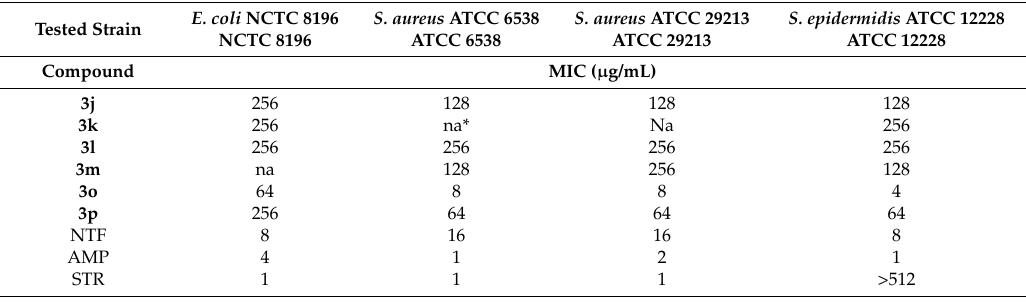
Table 6. In vitro antibacterial activity of 3j , 3k , 3l , 3m , 3o , 3p expressed as a minimal inhibitory concentration (MIC) ( µ g/mL). AMP: ampicillin, NTF: nitrofurantoin, STR: streptomycin. Tested Strain